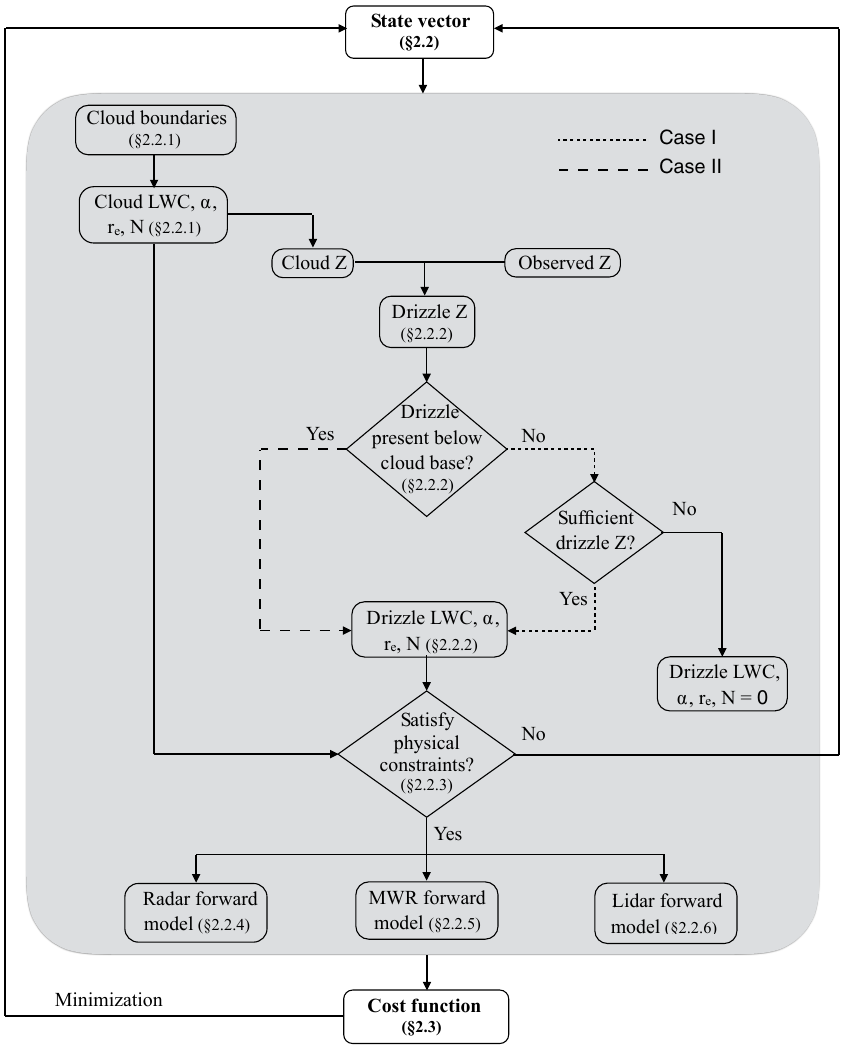
Figure 1. The retrieval flowchart. For each main step, a reference to the section that provides the details is given.